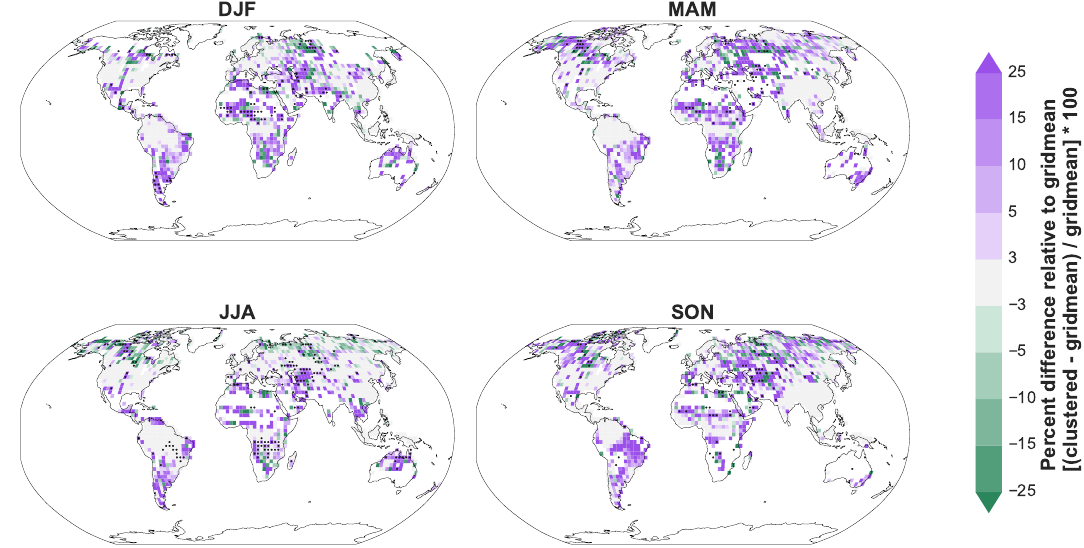
Figure A9. Percent difference in runoff between the Cluster and Gridmean simulations by season (mean of 1995–2015) following Fig.